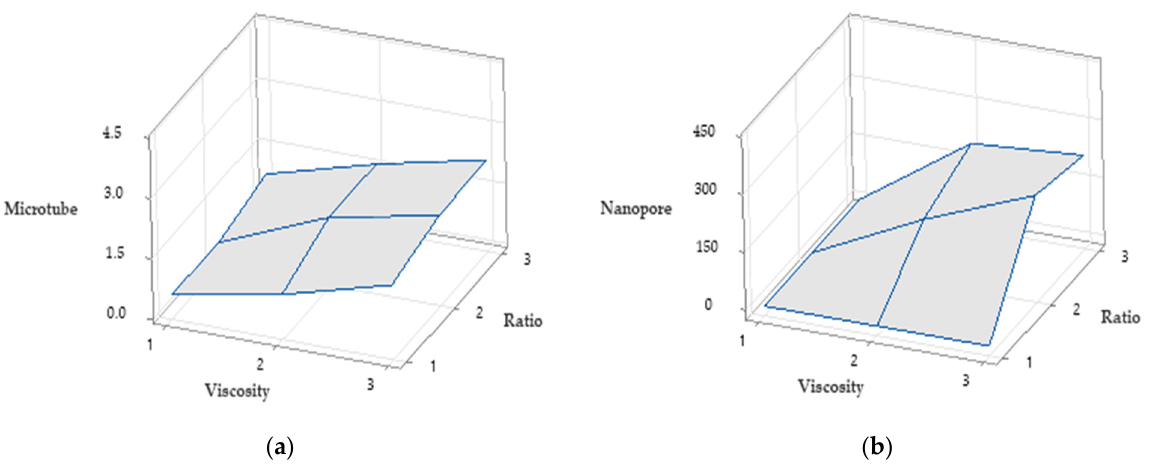
Figure 6. Surface change response of ( a ) microtubes and ( b )